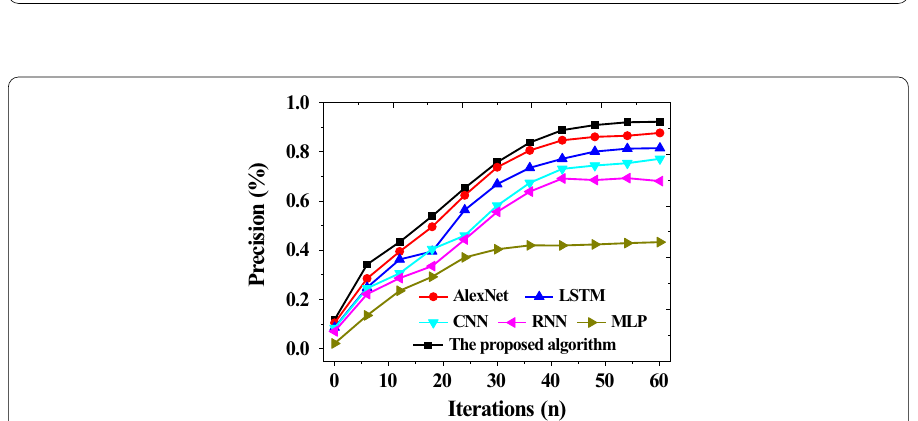
Fig. 6 Precision curves of different algorithms with the increase of iteration